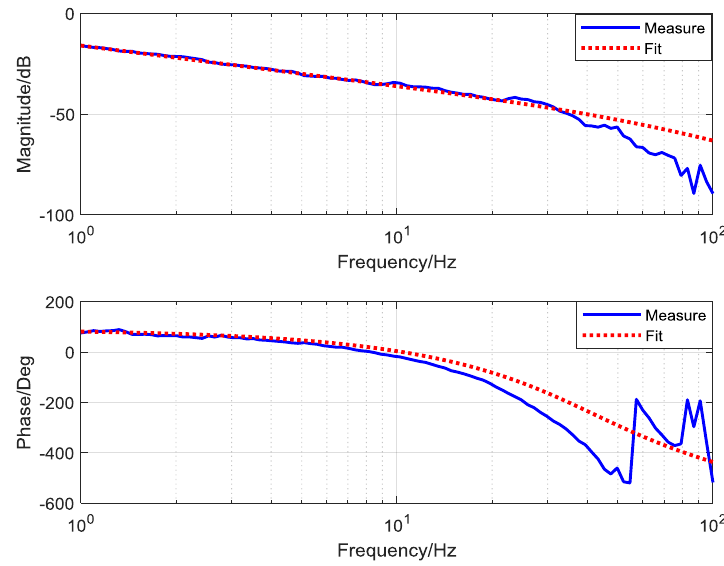
Figure 10. The open-loop characteristic position response of the controlled object.